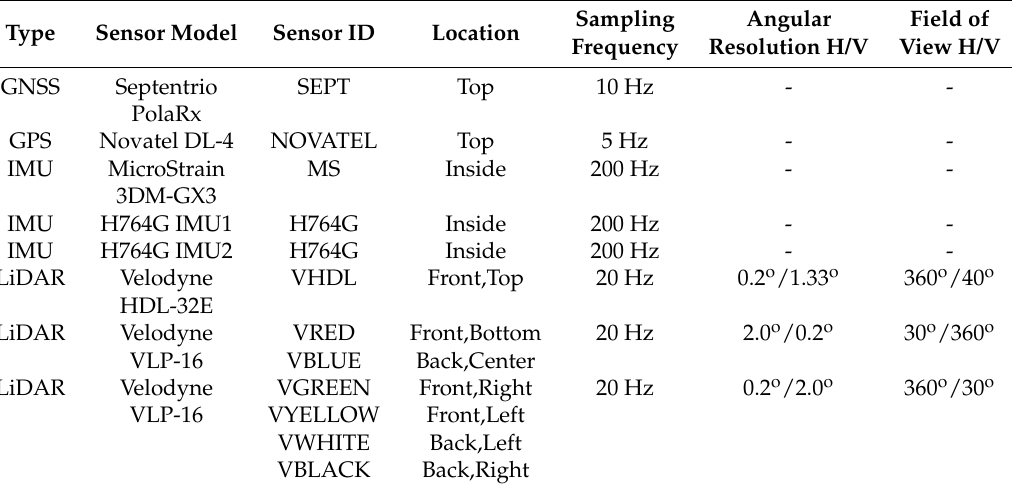
Figure 1. The carrier platforms with the sensor arrangement: ( a ) top view ( b ) front view. Table 1. Sensor